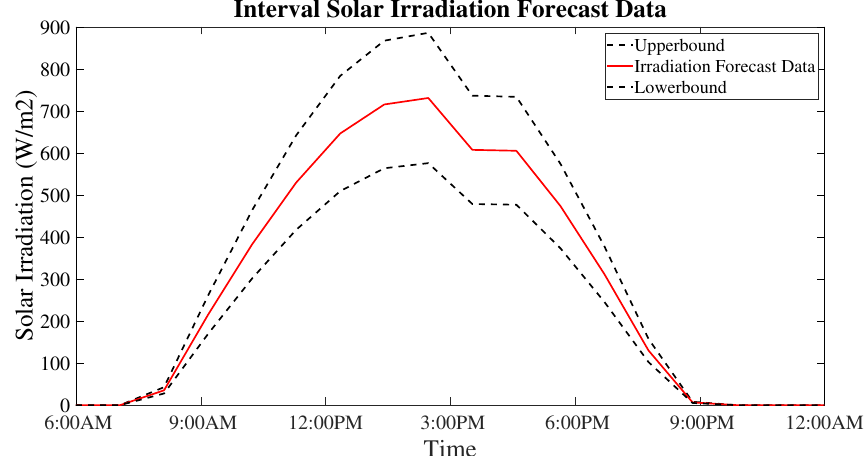
Figure 4. Interval solar irradiation forecast data in Singapore—5 February